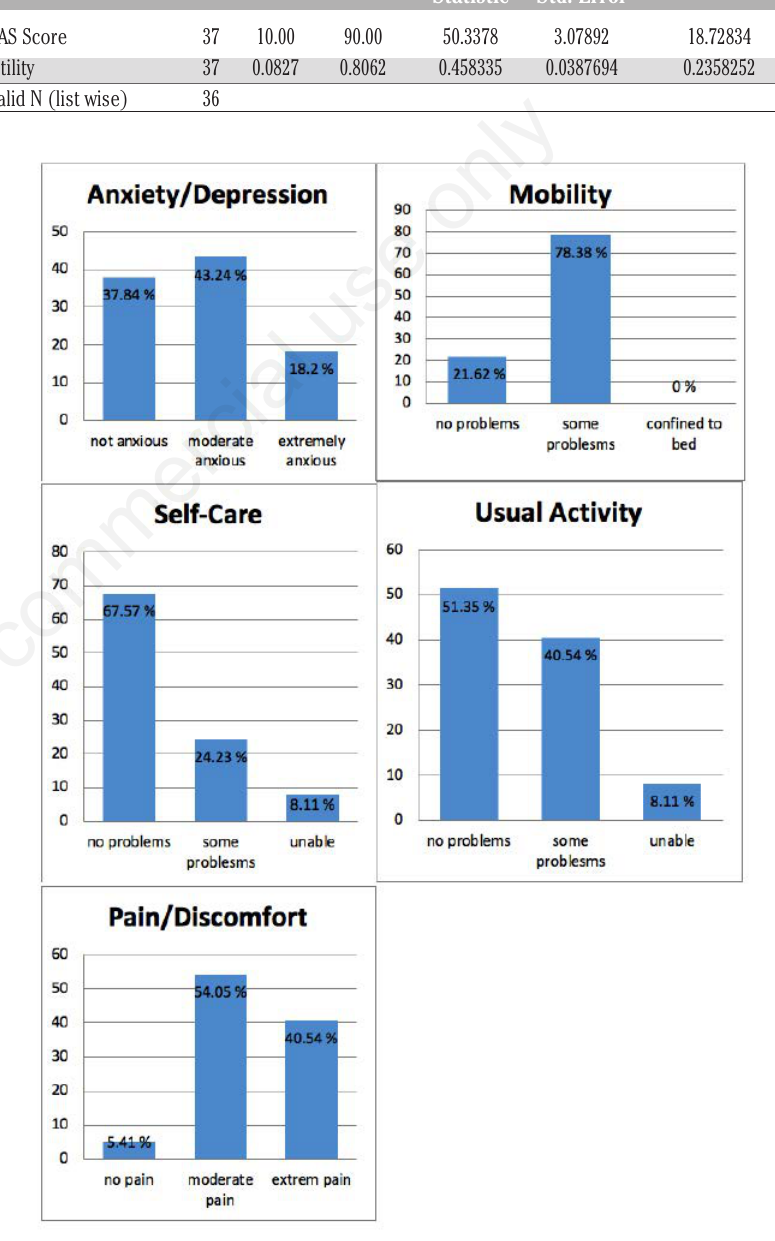
Figure 1. EQ-5D-3L health